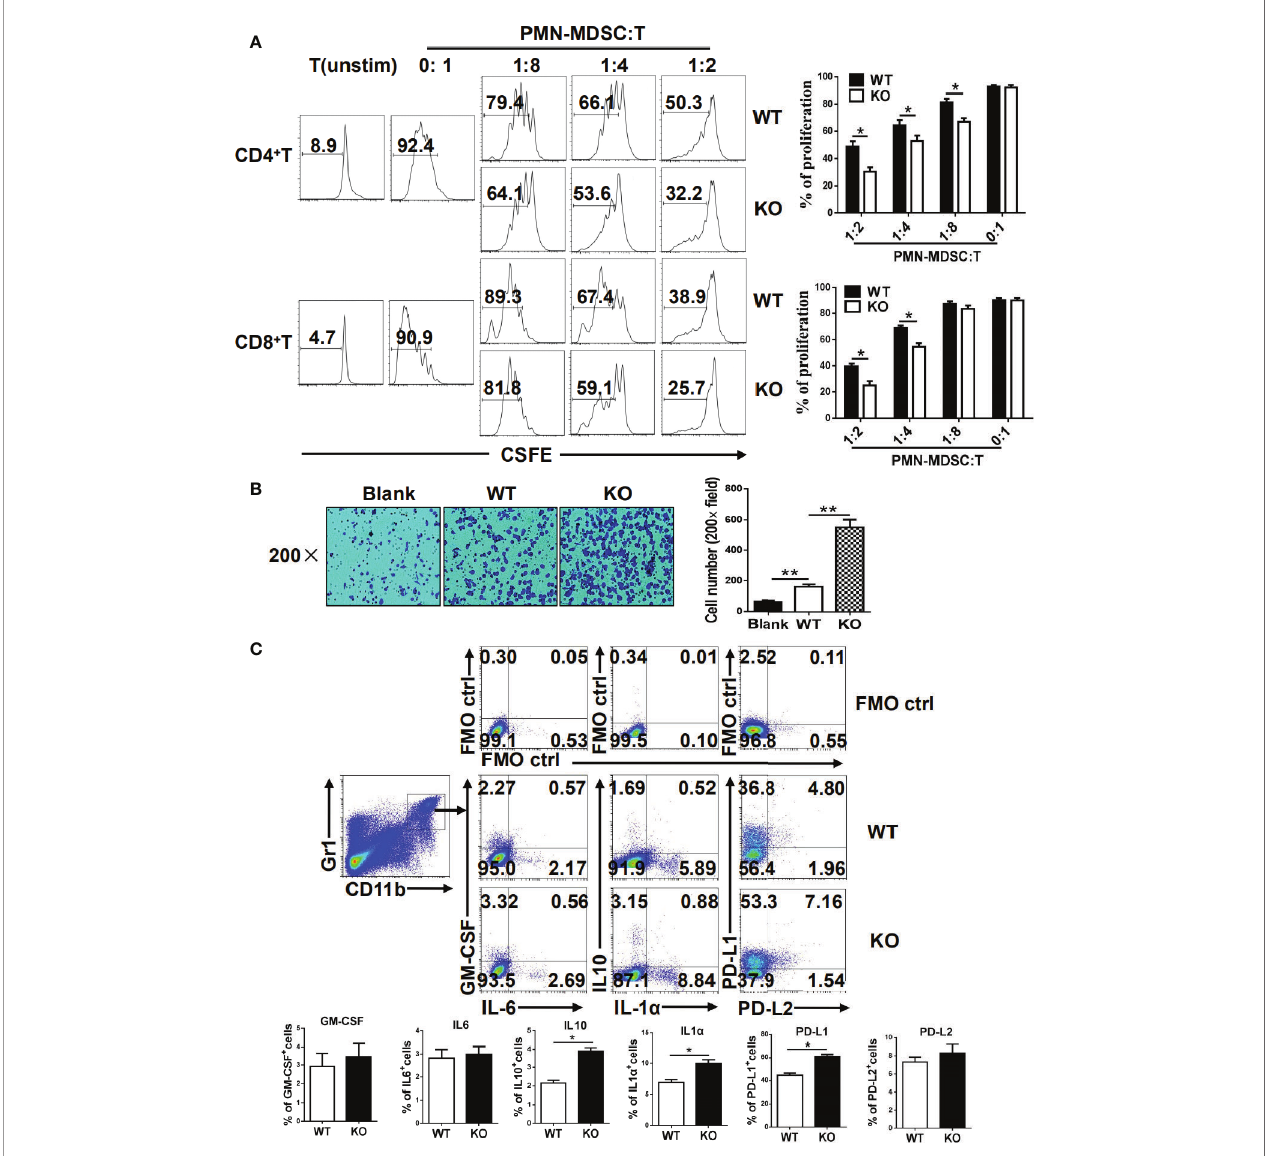
FIGURE 4 | Functional analysis of myeloid-derived suppressor cells (MDSCs). (A) Allogeneic mixed lymphocytes reaction. Allogeneic CD3 + T cells were stimulated with concanavalin A (ConA) and then cocultured with splenic G-MDSCs that were puri fi ed with Ly6G beads from the spleen of tumor-bearing mice at different ratios for 3 days. T-cell proliferation was evaluated by CFSE dilution; unstimulated T cells were used as a negative control. Representative data from single experiment (left) and mean ± SEM from three independent experiments (right) are shown. (B) B16 cells were cocultured with polymorphonuclear (PMN)-MDSCs, and a cell invasion assay was performed with Matrigel (crystal violet). Left, representative from a single experiment; right, mean ± SEMs from three independent experiments, * P < 0.05, ** P < 0.01, unpaired t test. (C) Single-cell suspensions of spleen cells from WT and IRF4 KO tumor-bearing mice were stimulated with PMA and ionomycin. The expression of PD-L1, PD-L2, GM-CSF, IL-1a, IL-6, and IL-10 were detected in MDSCs by FACS. Numbers in the quadrants are the percentages of cells in each expression phenotype (n = 5 mice per group). A representative of two independent experiments is